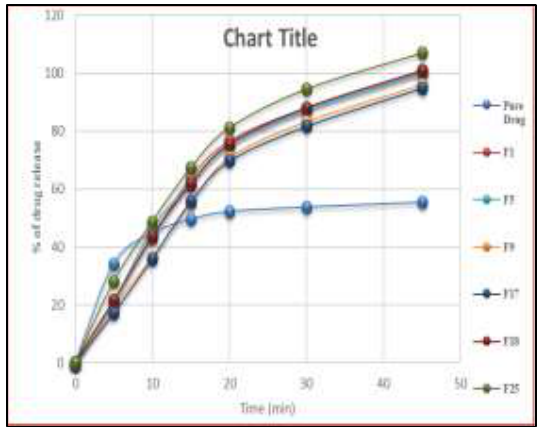
Figure 6. The release profile of risperidone nanosuspension in 0.1N HCl